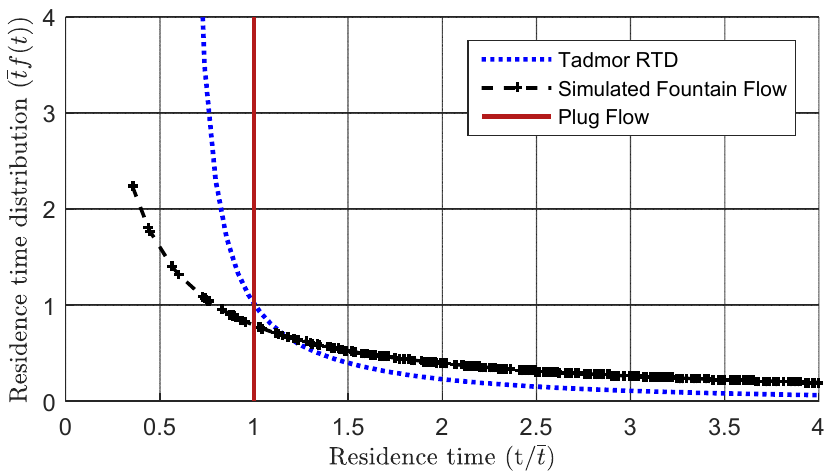
Figure 10. Residence time distribution derived from particle tracking, showing a broader residence time distribution than predicted by Pinto and Tadmor.